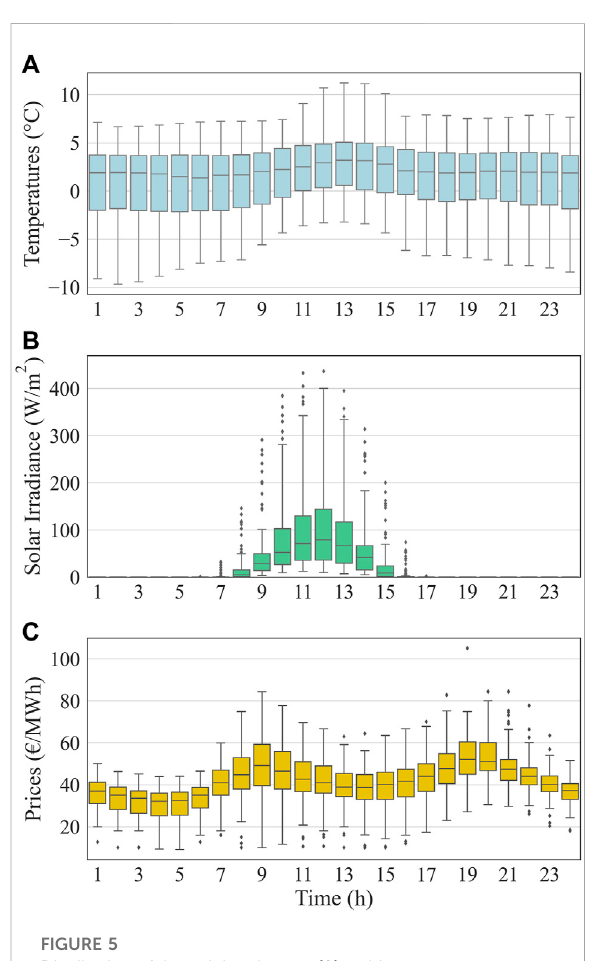
FIGURE 5 Distribution of the training dataset: (A) ambient temperature, (B) solar radiation, and (C) electricity